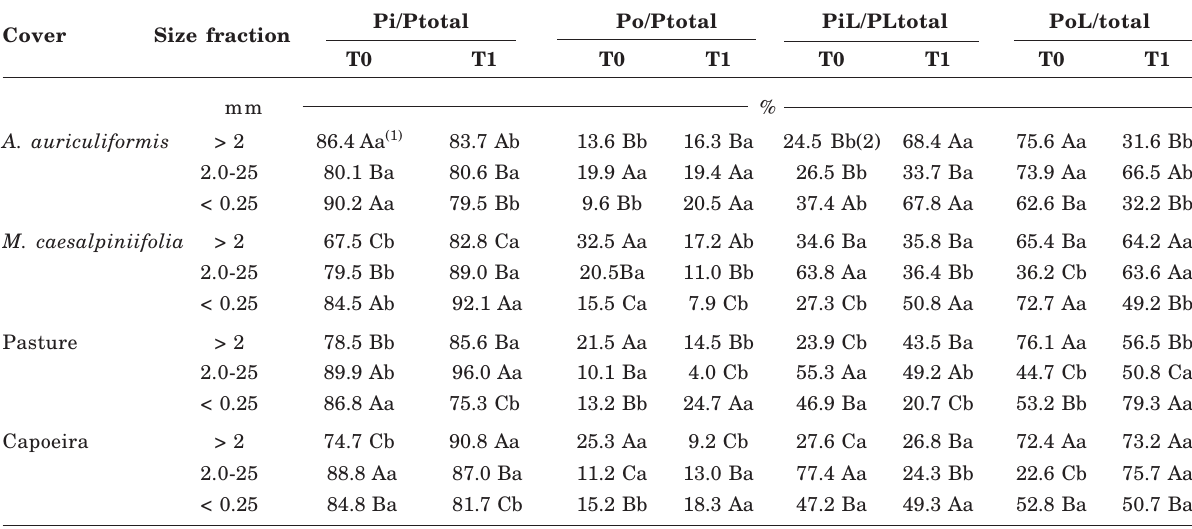
Table 6. Percentage distribution of total inorganic (Pi), organic (Po), labile inorganic (PiL) and organic (PoL) phosphorus contents of soil size fractions under leguminous trees, pasture and capoeira at time zero (T0) and after 90 d of incubation